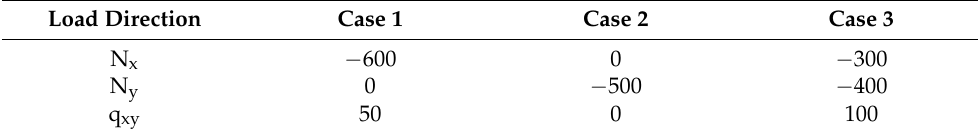
Table 1. Common carbon fiber-based and organic fiber materials (case 1-3). Load